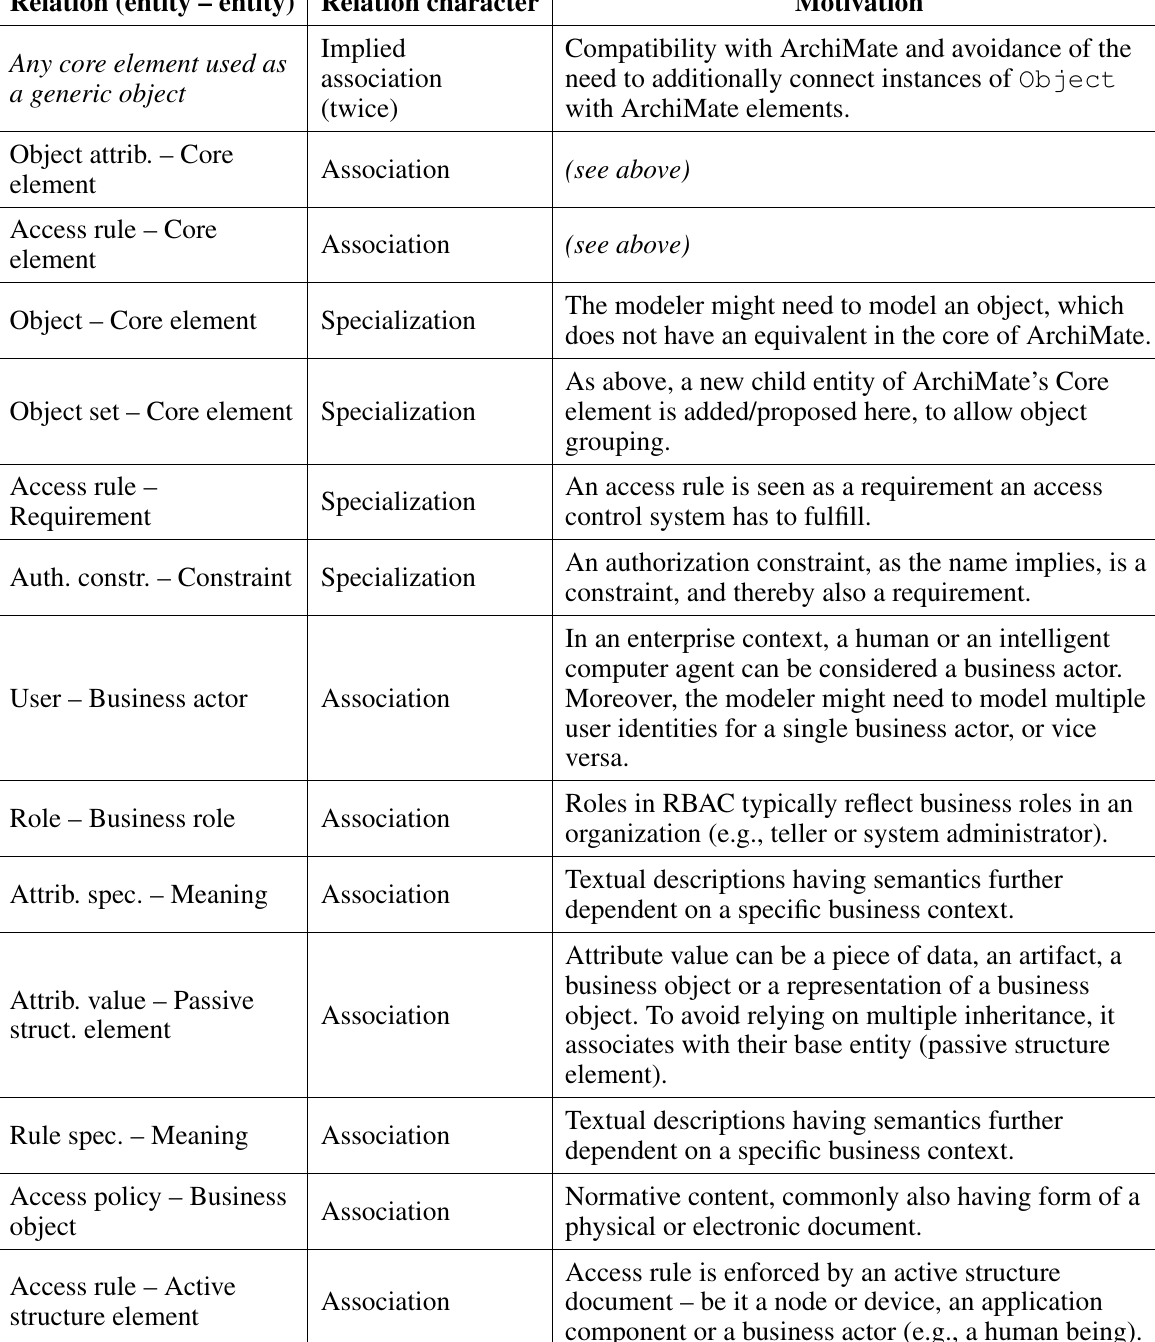
Table 4. Mapping of the proposed unified metamodel to